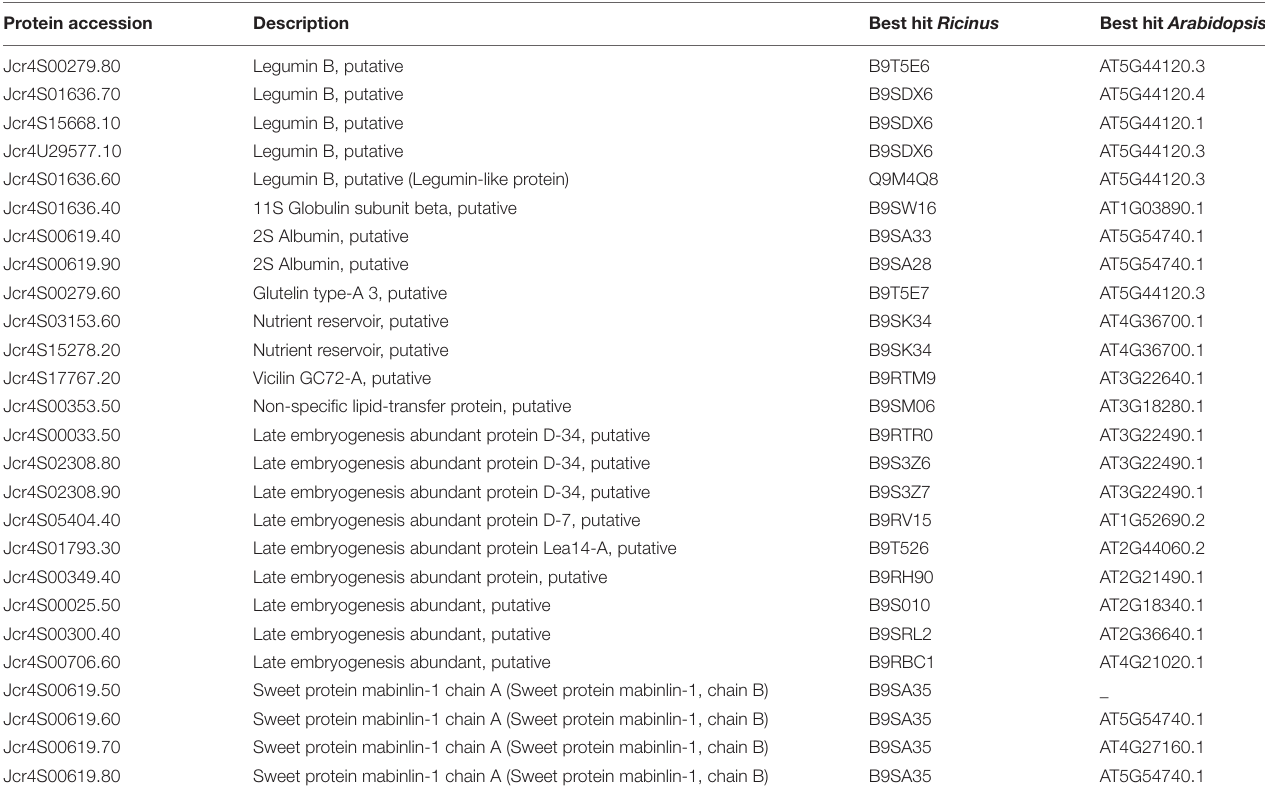
TABLE 4 | Seed storage related proteins identified from the embryo of mature J. curcas . Protein